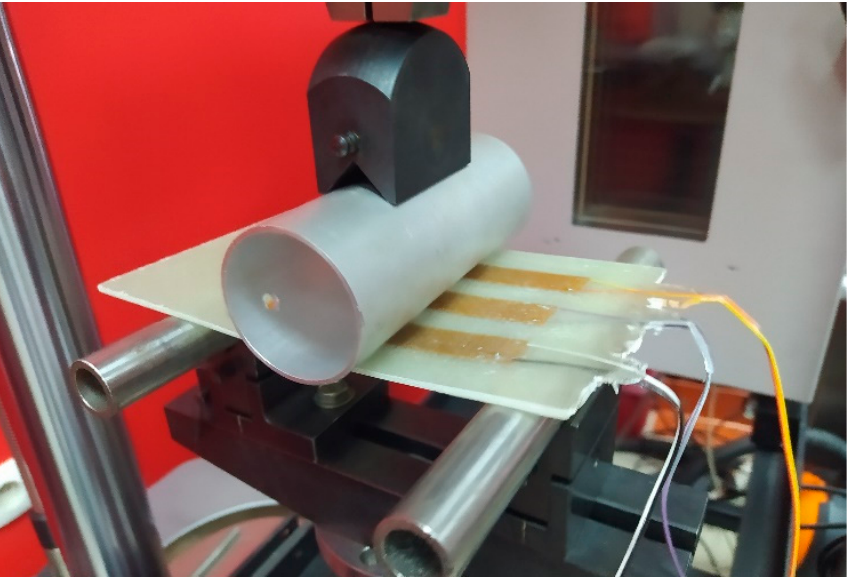
Figure 2. Laminated MFC transducers equipped with thermal chamber and electro-pulse wave generator—cyclic concentric load.